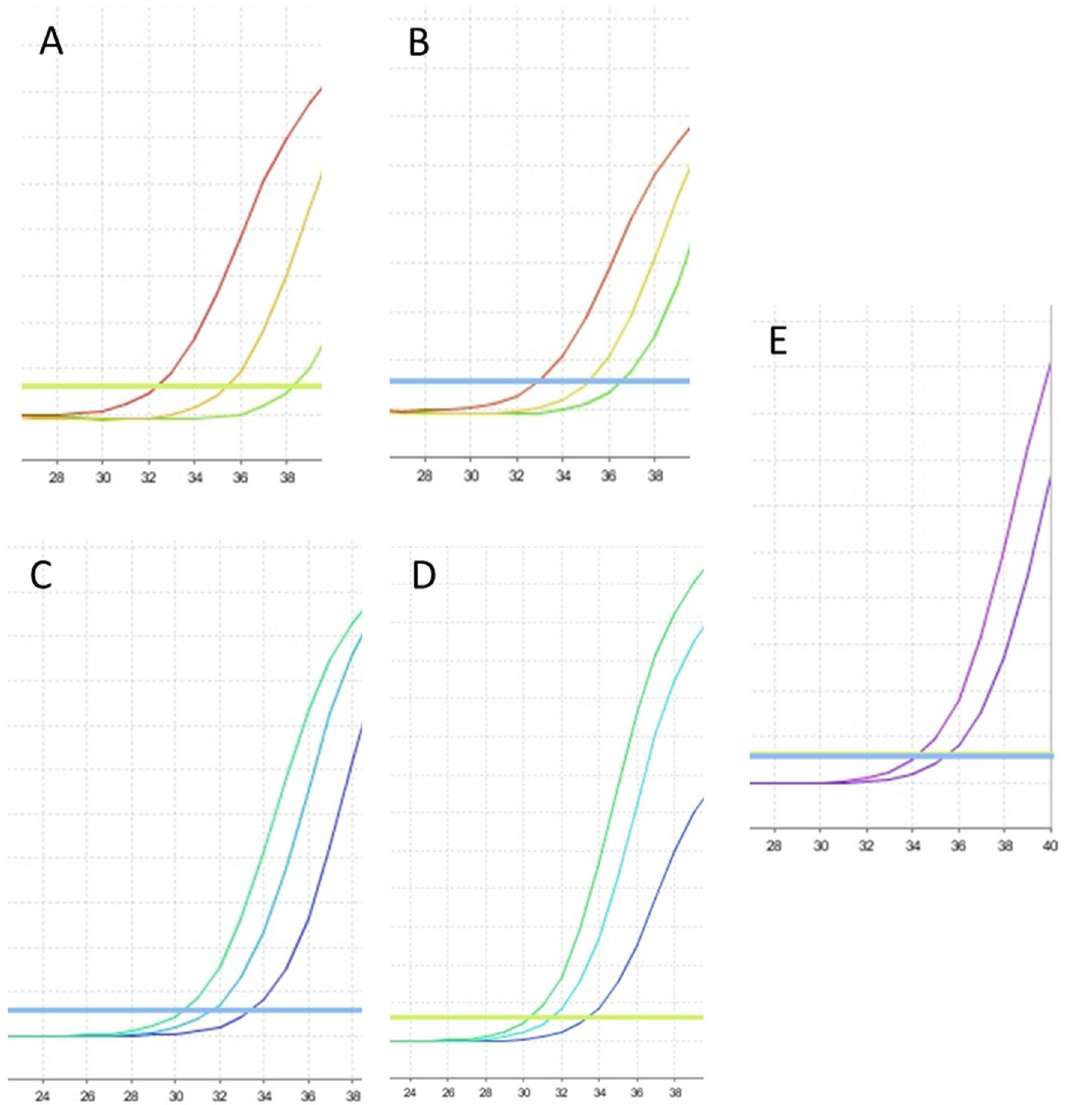
Figure 1. Real-time reverse transcription amplification curves using master mix without uracil DNA glycosylase (UDG) activation. ( A ) Dilutions of ssDNA (500 ng, 100 ng and 50 ng) from SARS-CoV-2 positive samples amplified by the 3 ′ primer of the hCOVassay1 set. ( B ) Three different dilutions of ssDNA (500 ng, 100 ng and 50 ng) from SARS-CoV-2 positive samples amplified with the 3 ′ primer of the hCOVassay2 set. ( C , D ) The three dilutions of ssDNA (100 ng, 50 ng and 10 ng) from SARS-CoV-2 positive samples produced with the random primers methodology and amplified with the ( C ) hCOVassay1 and ( D ) hCOVassay2 primers. ( E ) Amplification curves of negative controls produced using the two primer sets using 3 ′ primer ssDNA method. The negative control was from a negative